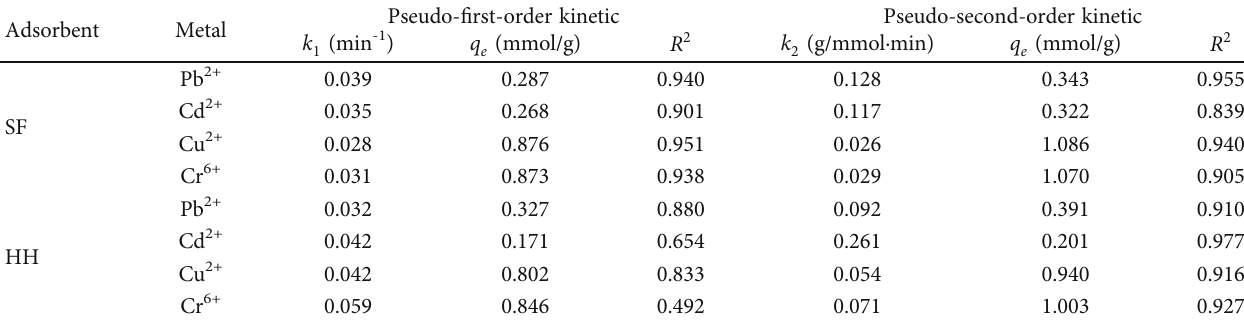
Table 3: Adsorption kinetic parameters calculated for the removal of Pb 2+ on HH and SF at 298K and pH 4.